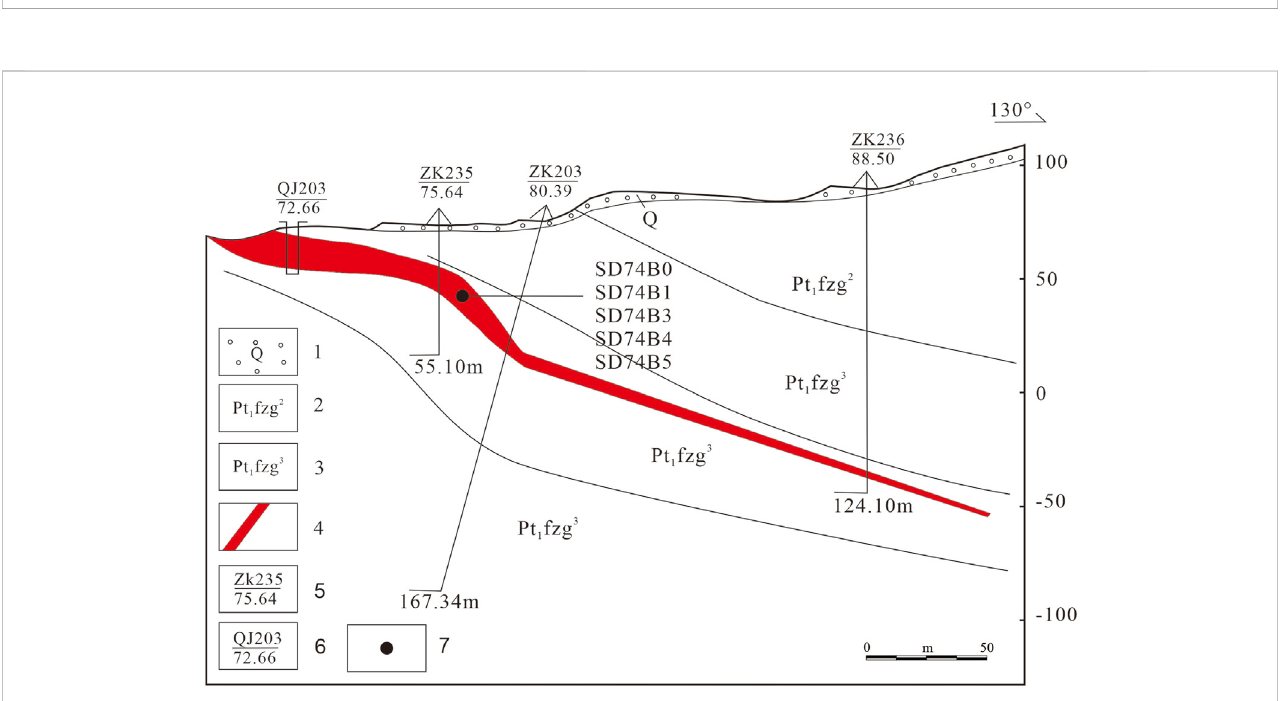
FIGURE 3 Geological pro fi le along No. 252 line of the Yangjiakuang gold deposit, showing the sampling sites in this study (after Yu et al., 2014). 1. Quaternary; 2. Second member of the Zhanggezhuang Formation; 3. Third member of the Zhanggezhuang Formation; 4. Gold vein; 5. Drill hole; 6. Drilling shallow well; 7. Sample